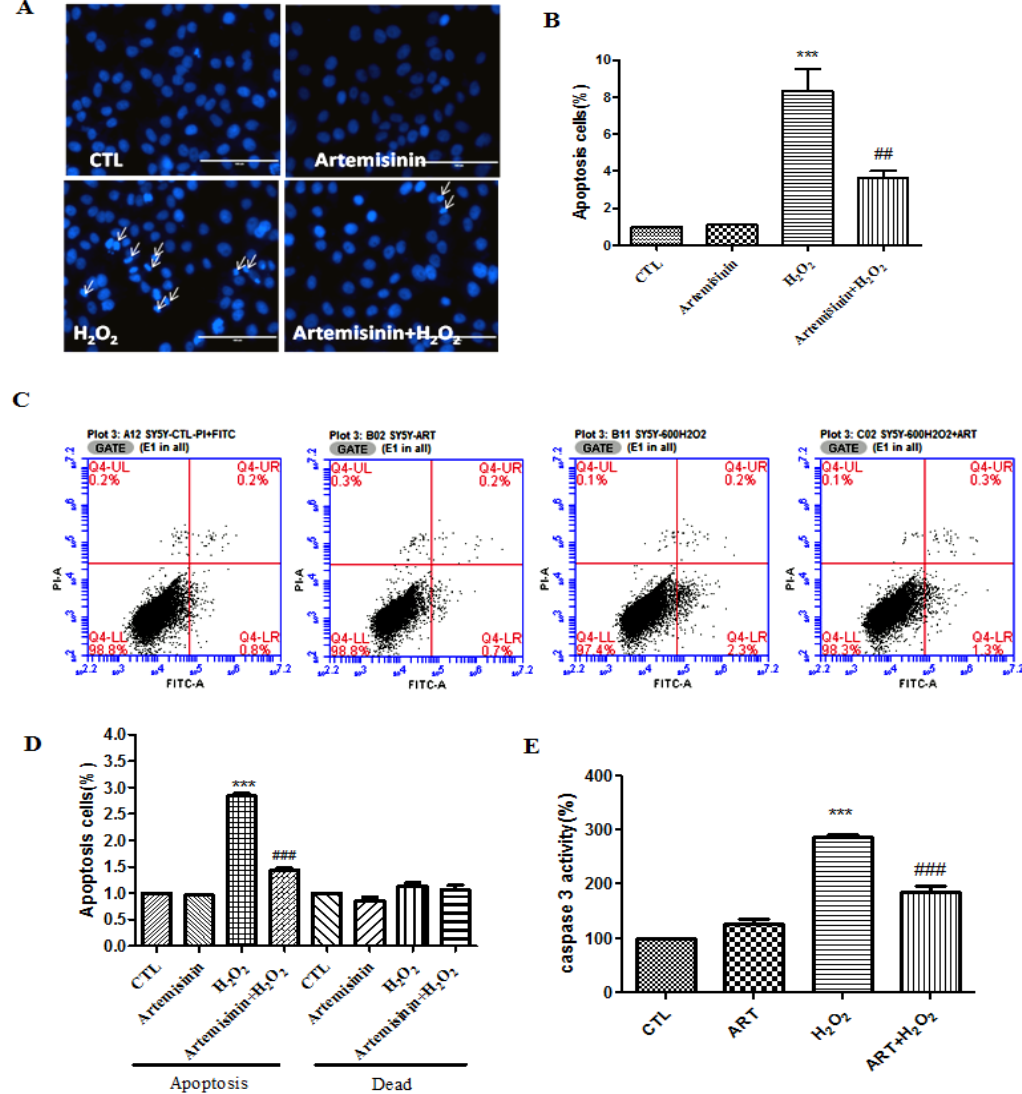
Figure 2. Artemisinin suppressed H 2 O 2 -induced apoptosis in SH-SY5Y cells. Cells were pre-treated with 12.5 µ M artemisinin for 2 h and then induced with or without 600 µ M H 2 O 2 for another 24 h. The pictures have been taken at a magnification of 40 × (100 µ m). ( A ) Photographs of representative cultures measured by Hoechst staining. Apoptotic cells are marked with white arrows ( B ) Quantitative analysis of ( A ). ( C ) Photographs of representative cultures measured by flow cytometry. ( D ) Quantitative analysis of ( C ). ( E ) The activity of caspase-3 was monitored by caspase assay. Data represent means ± SD, *** p < 0.001, ## p < 0.01, ### p <0.001.